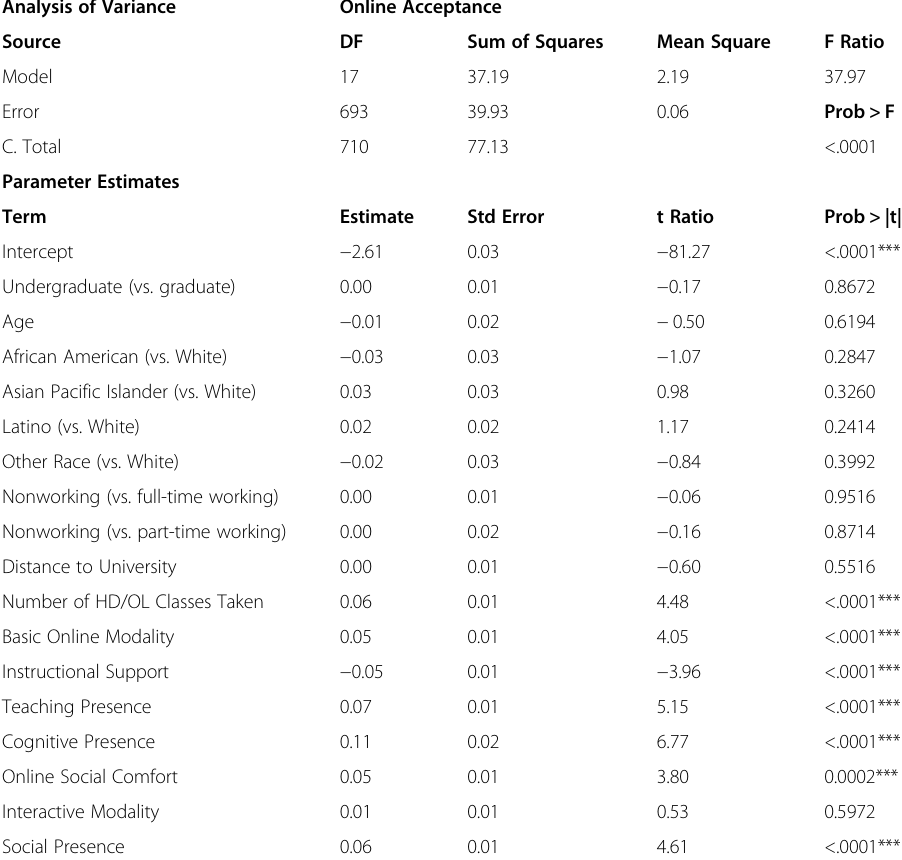
Table 7 Summary of Multiple Regression Analysis: Online Class Acceptance Analysis of